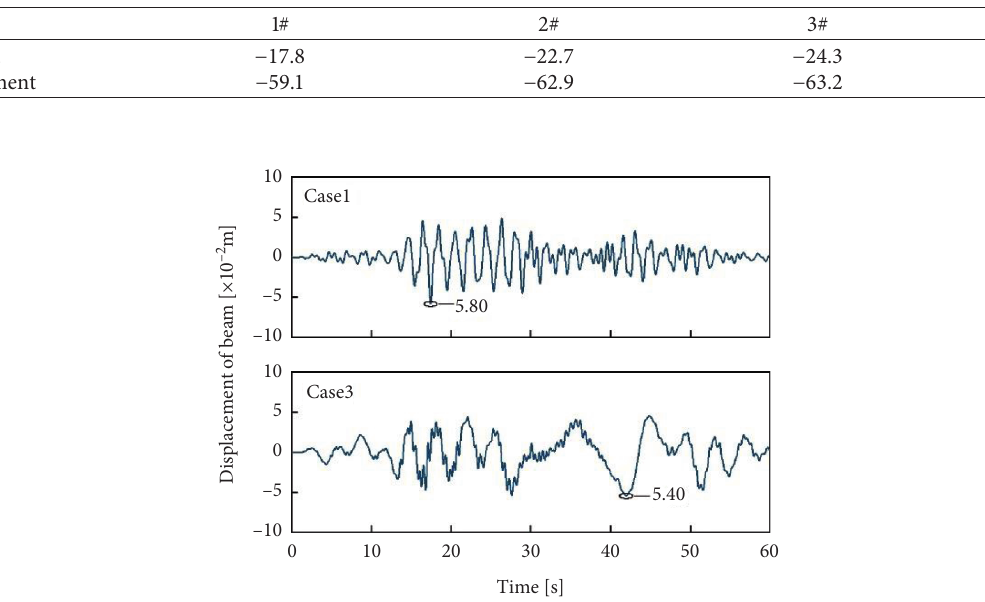
Figure 12: Displacement envelopes of piers in Cases 1 and 3. Table 6: Response difference rates for Case 1 and Case 3 (%).